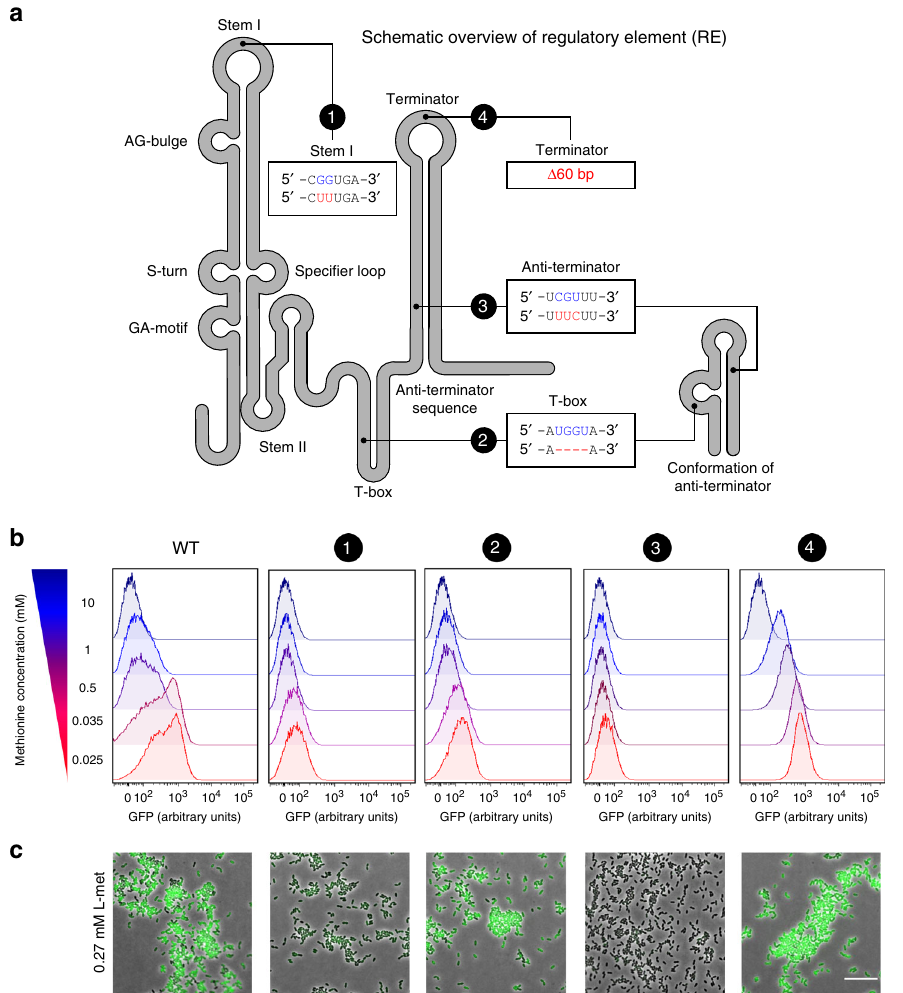
Fig. 6 Regulation of the methionine sensing by structural elements of the T-box riboswitch. a Secondary structure diagram of the regulatory element (RE; T-box riboswitch) used in this study. The four introduced mutations to the T-box are shown in red and with numbers (1 – 4). Highly conserved domains in T-box riboswitches are indicated. b Single-cell fl uorescence measurements by fl ow cytometry, in the met promoter-driven expression of GFP in the L. lactis Pmet-gfp (WT) and each of the four mutants of the regulatory element in the met promoter (1 – 4), grown in CDM supplemented with increasing concentrations of methionine (0.025 – 10 mM; red to blue). 10,000 ungated events for each sample are shown. Source data are provided as a Source Data fi le. c Snapshots of single-cell fl uorescence microscopy in all the L. lactis Pmet-gfp strains, grown in standard CDM (0.27 mM methionine). Scale bar, 15 µ